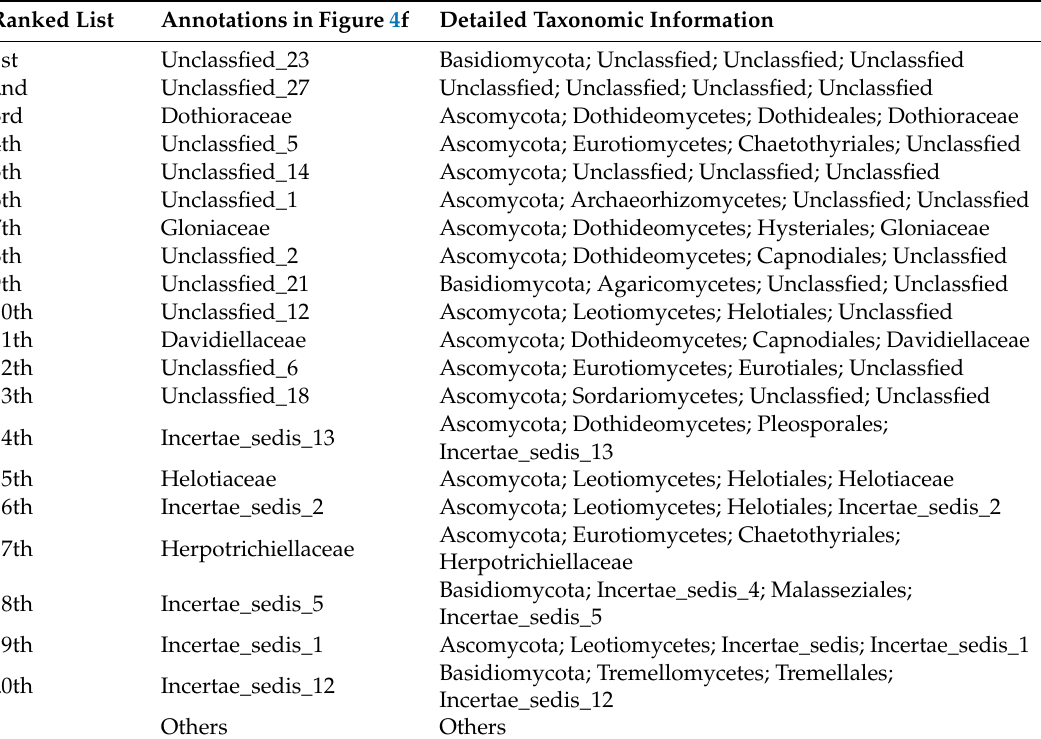
Table A4. The detailed taxonomic information of the top 20 fungi of unfertilized eggs samples on family